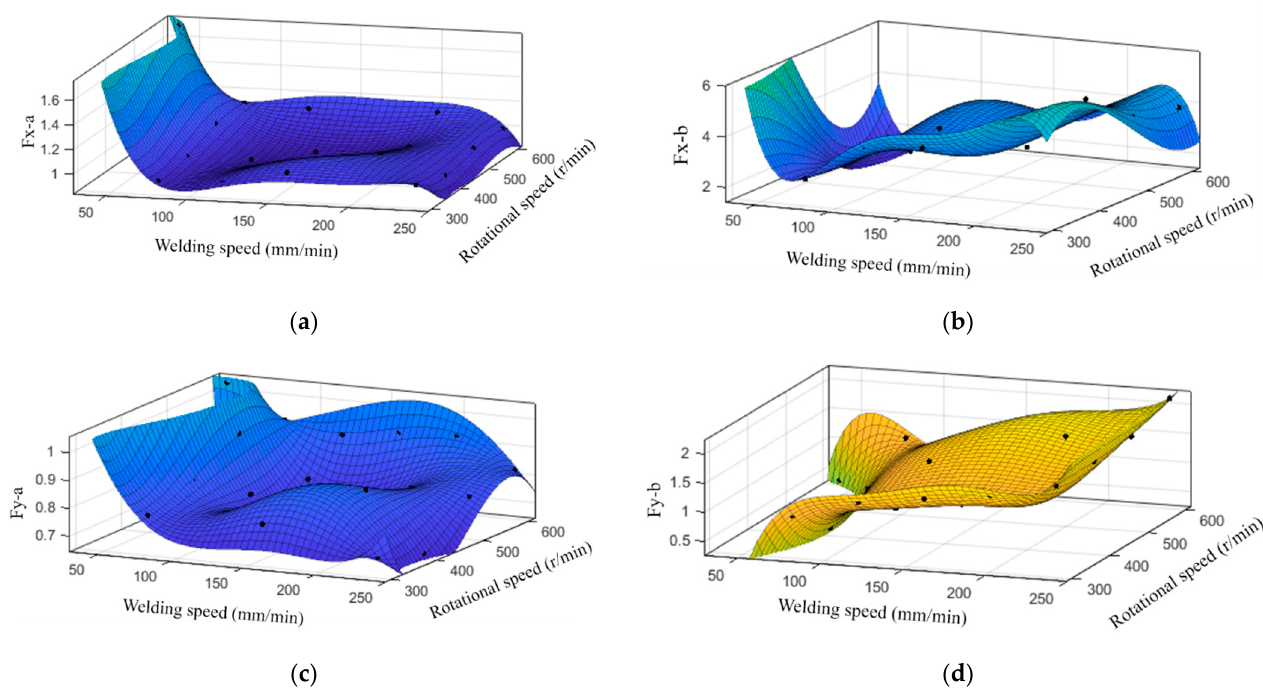
Figure 9. The fit results of force parameters: ( a ) Constant term and ( b ) coefficient term of Fx; ( c ) Constant term and ( d ) coefficient term of Fy. Table 5. Fit results of force